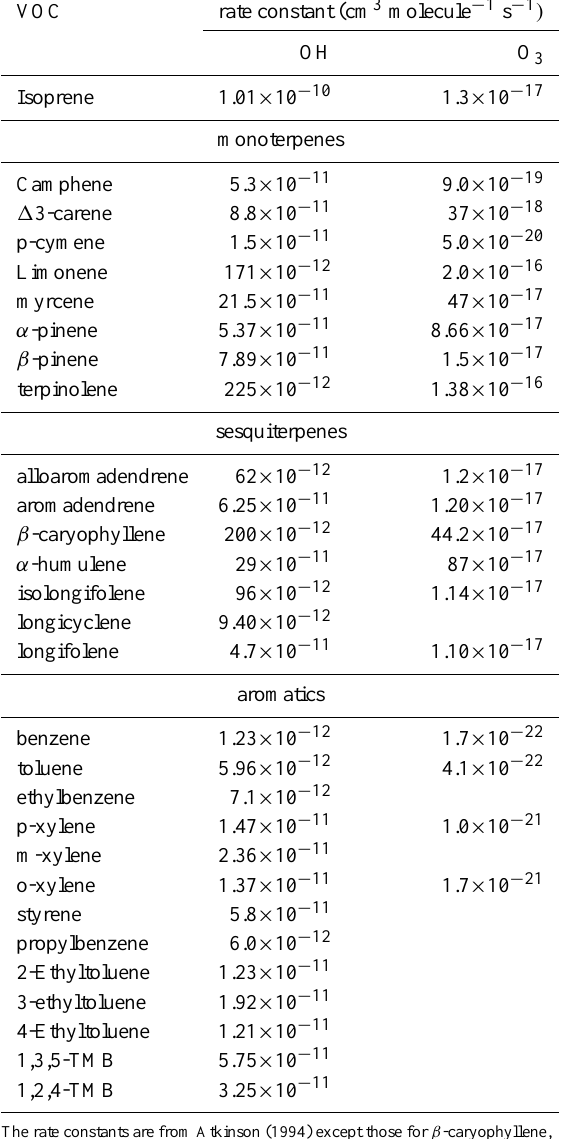
Table 1. Reaction rate coefficient of VOCs with hydroxyl radical and